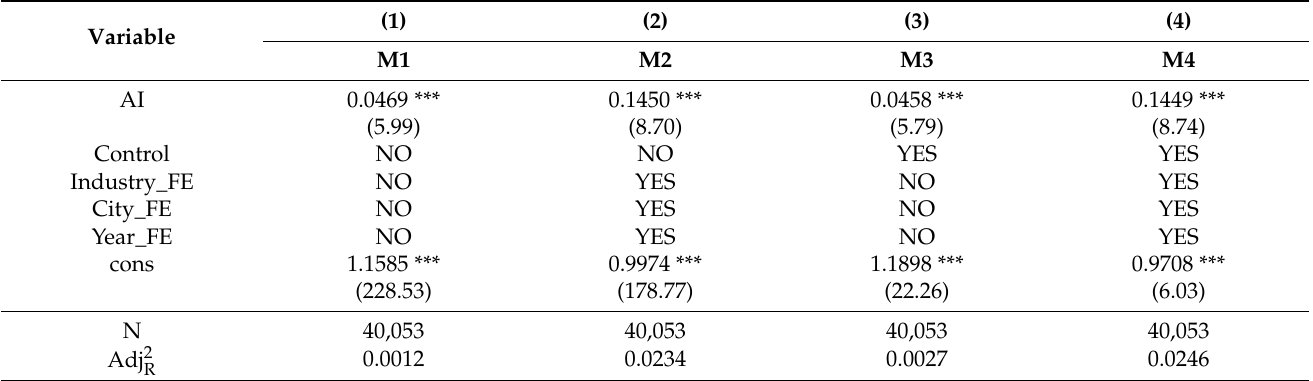
Table 3. Benchmark